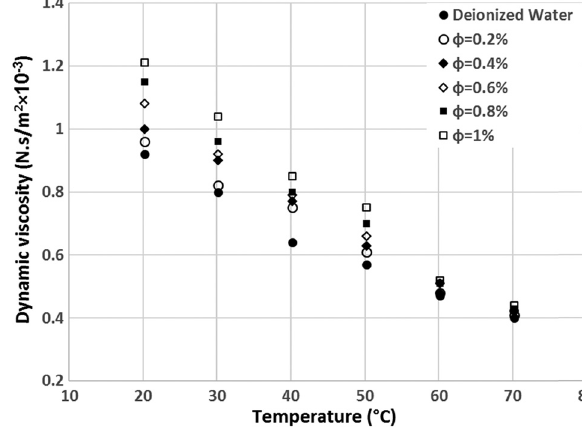
Figure 3: Dynamic viscosity measurements of CuO – Cu nano fl